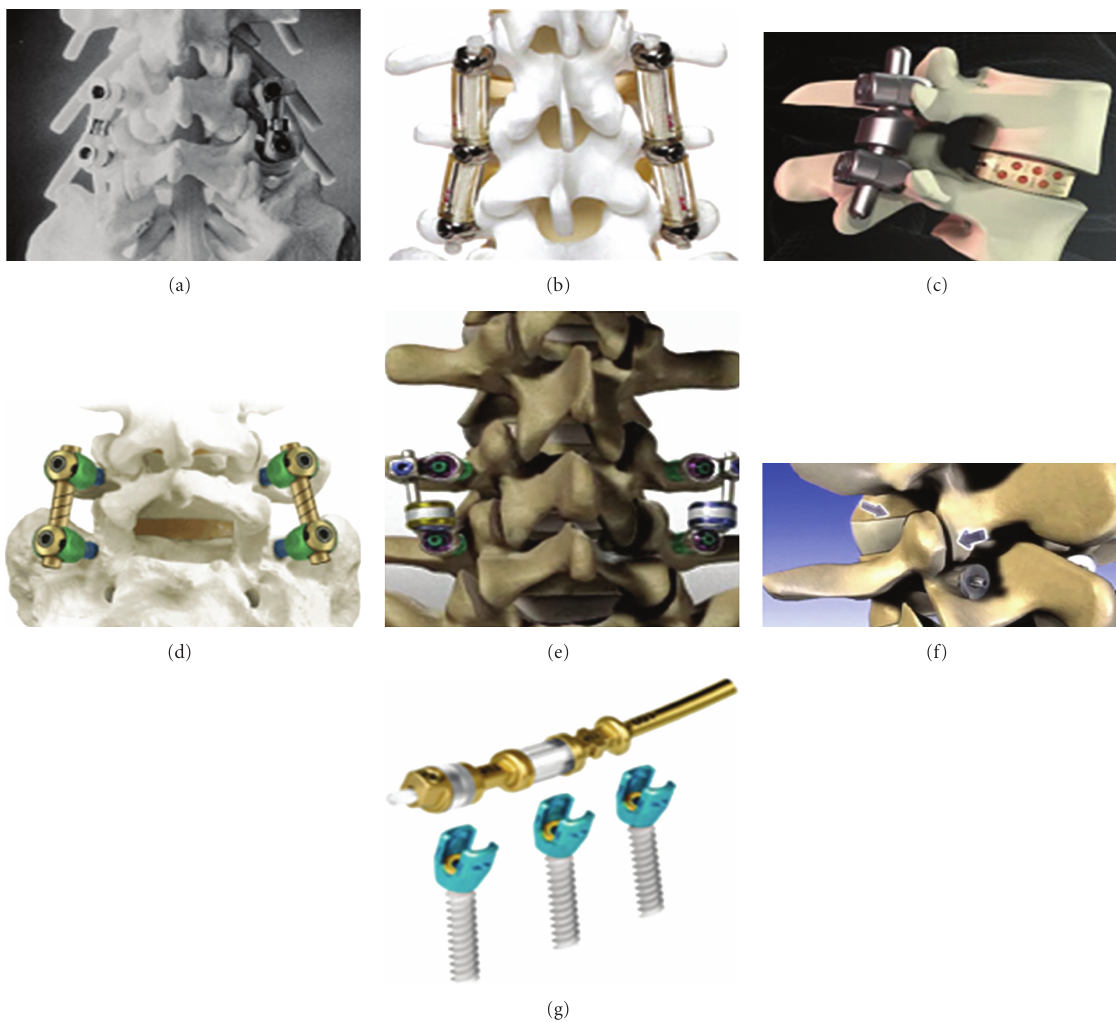
Figure 9: Posterior dynamic stabilization systems. (a) Graf system; (b) Dynesys; (c) IsoBar; (d) AccuFlex; (e) Stabilimax; (f) PercuDyn; (g) Transition